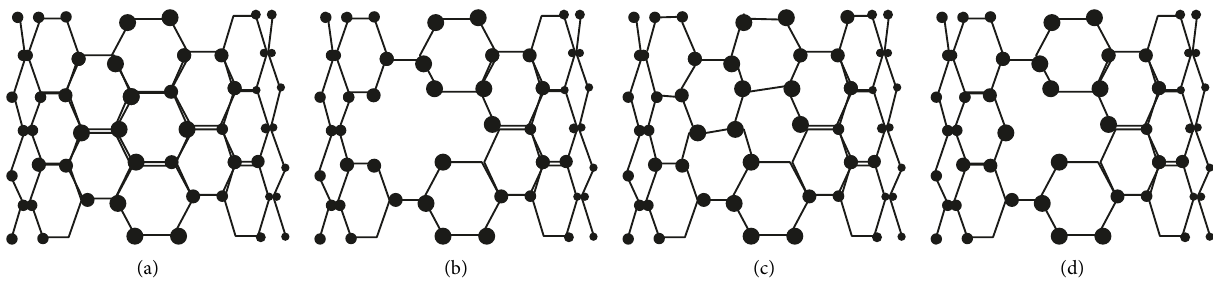
Figure 1: Schematic diagram of carbon nanotubes and their defects. (a) Intact carbon nanotubes. (b) diatomic defect. (c) shape defect. (d) cell vacancy